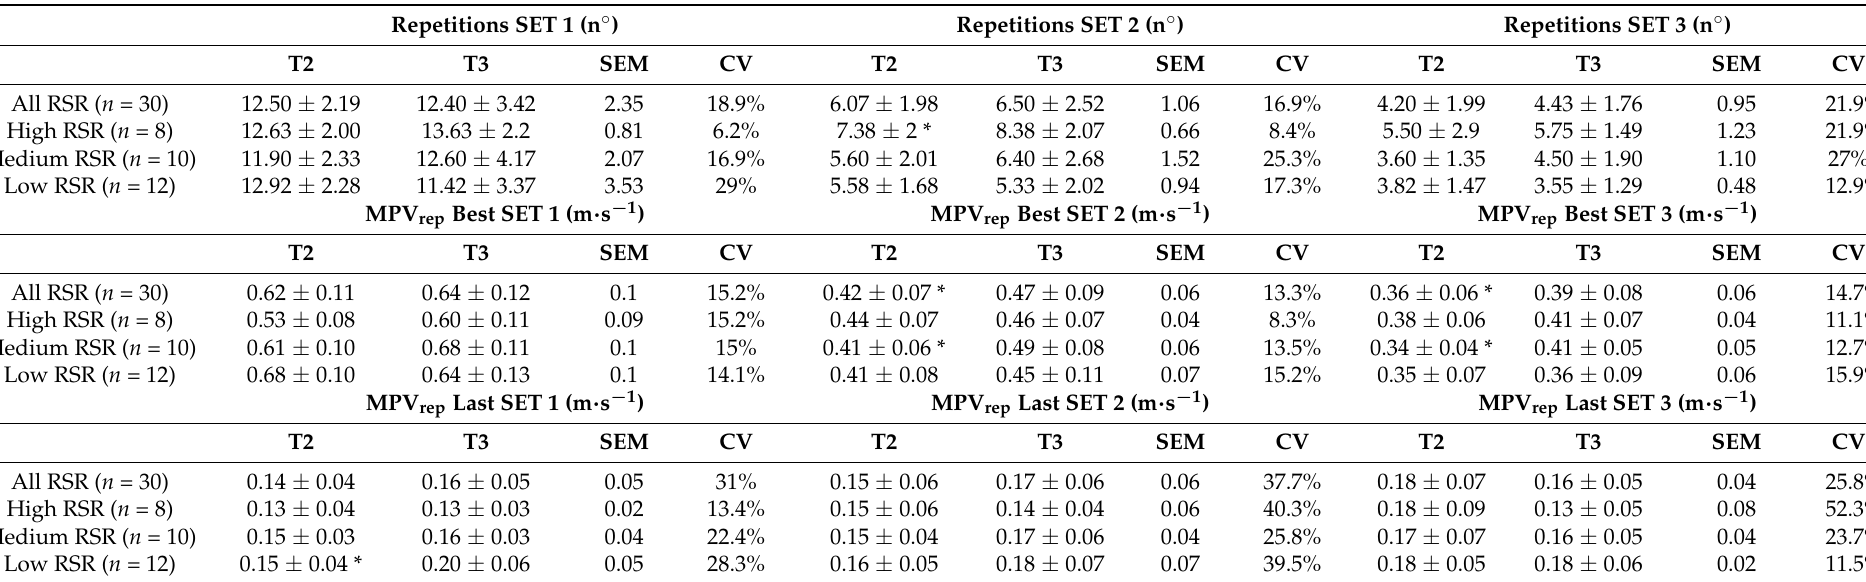
Table 3. Intrasubject variability in the number of repetitions of the bench press exercise protocol performed, best repetition and last repetition, on two different days for the four strength